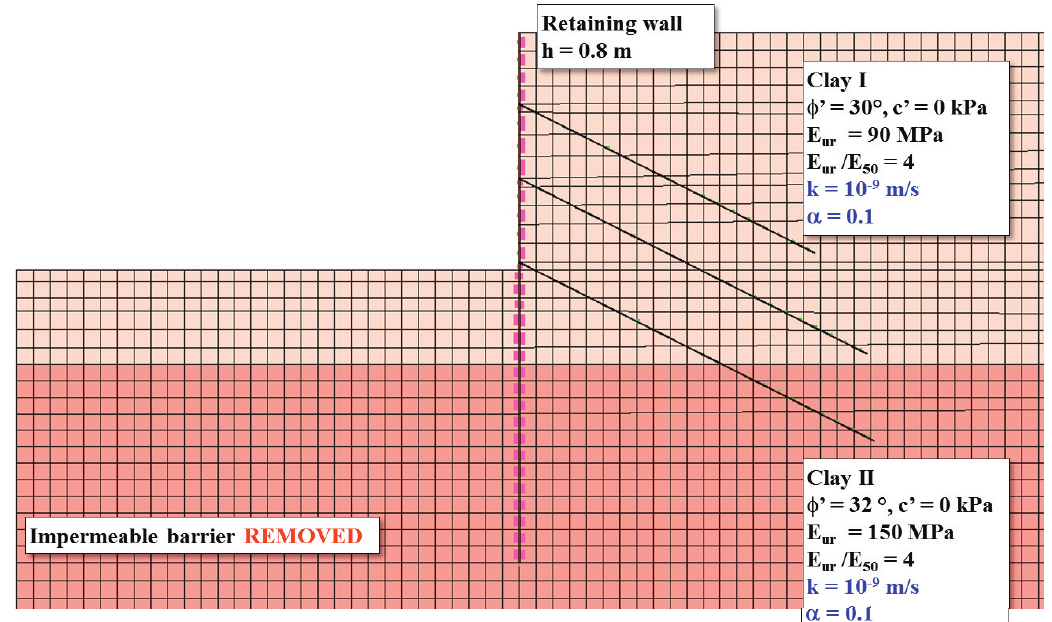
Fig. 13. Modification of the model presented in Fig. 4 for simulation of a hypothetical excavation in low permeable